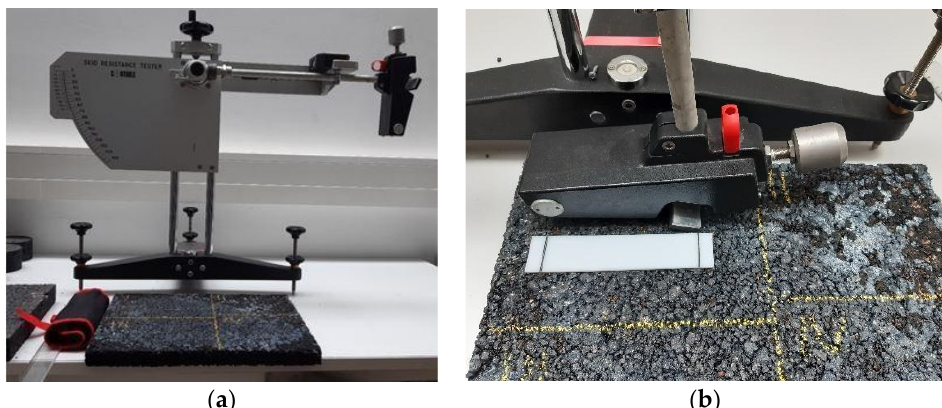
Figure 2. SRT device in the experiment setup ( a ) and close-up view of measurement setup ( b ).